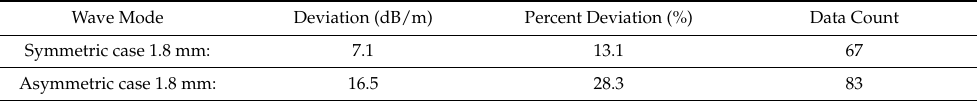
Figure 14. ( a ) Observed α –S o values for 1.8-mm PMMA sheet along with the calculated attenuation and dashed lines for α L and α T . Three test series are plotted using blue symbols. Dot data used Olympus V101 Tx and PAC Pico Rx, + symbols used Olympus V101 Tx and KRN-BB-PC Rx and triangles used NDT C16 Tx and KRN-BB-PC Rx. All with short-pulse excitation. Vertical bar shows 2 × dev. ( b ) Observed α –A o values for 1.8-mm PMMA sheet along with the calculated attenuation and dashed lines for α L and α T . Three test series are plotted using red symbols. Dots used KRN-BB- PCP Tx on the sheet 5 mm from an edge and KRN-BB-PC Rx, + symbols used NDT C16 Tx at 60 ◦ incident angle and PAC Pico Rx, and triangles also used NDT C16, but with KRN-BB-PC Rx. All with short-pulse excitation. Vertical bar shows 2 × dev. Calculated values of deviation and percent deviation were averaged and are listed